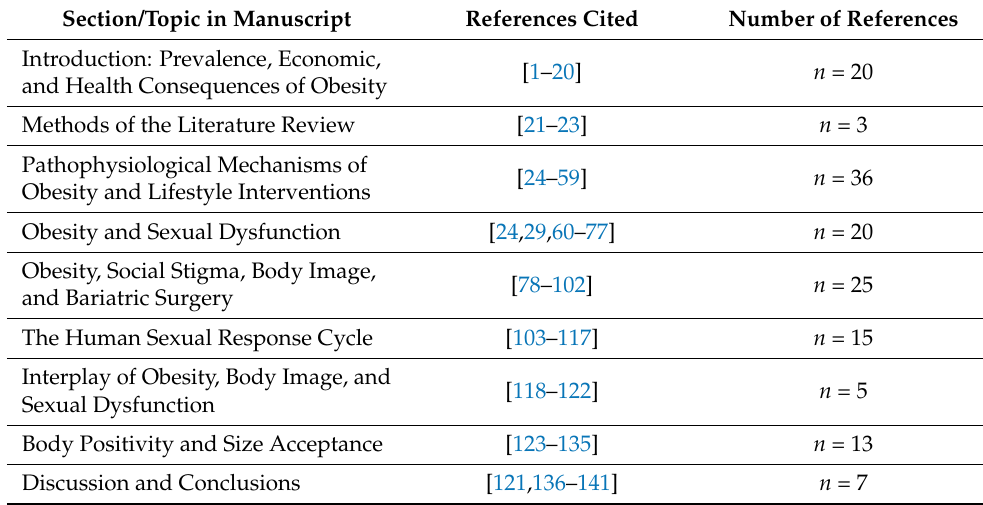
Table A1. Parenthetical citations for each of the manuscript